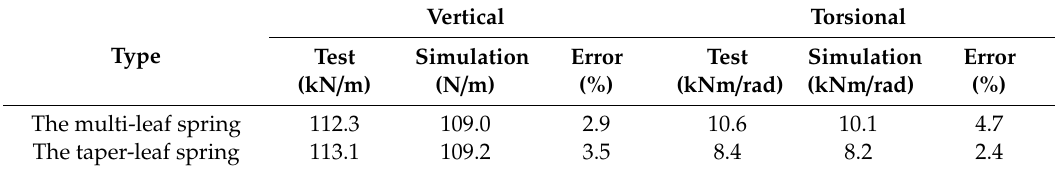
Figure 6. The test equipment. Table 2. A comparison of the stiffness values.